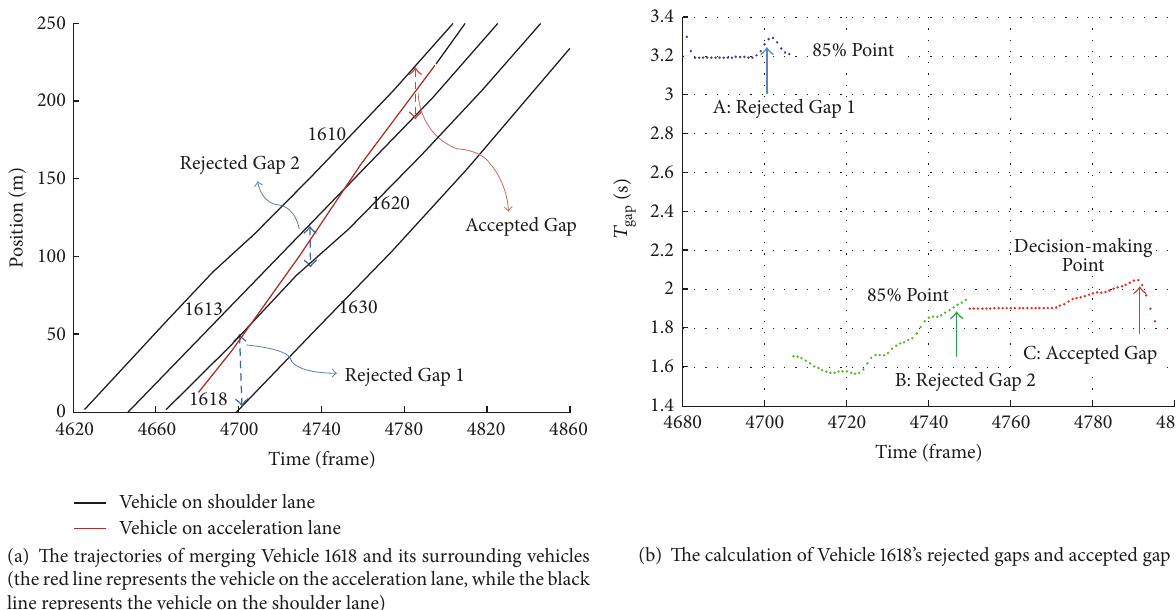
(a) The trajectories of merging Vehicle 1618 and its surrounding vehicles (theredlinerepresentsthevehicleontheaccelerationlane,whiletheblack line represents the vehicle on the shoulder lane) Figure 3: An example of a merging process at LA.